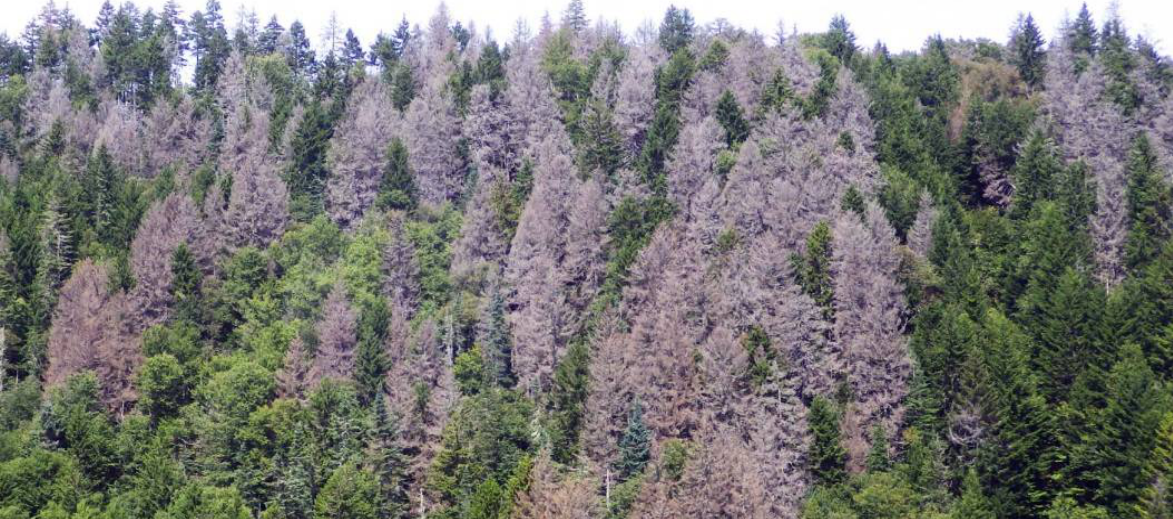
Figure 1. An example of widespread mortality in a young natural spruce forest. Note the survivors.